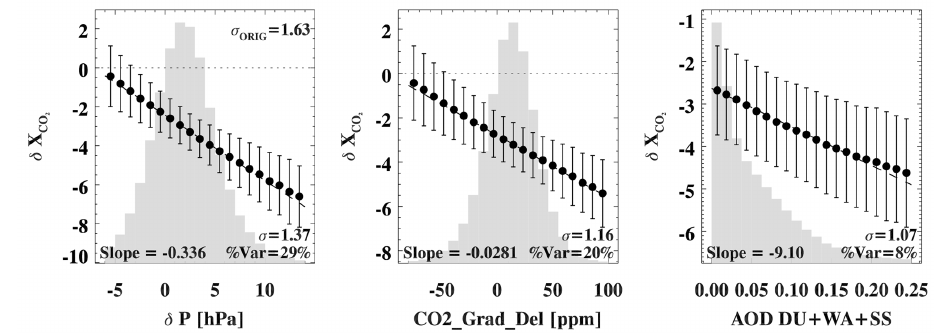
Figure 13. Multi-linear bias-correction fit to the three variables used for land soundings. Here, land nadir and glint observations are shown, with the multi-model median truth proxy. The circles show mean values in each parameter ( x axis) bin, and the error bars are the 1 σ standard deviations within each bin. The histogram shows the distribution of the parameter. The legend in each panel shows the starting and ending standard deviations after application of each variable, and the coefficient for that variable of the multiple regression using all three variables.